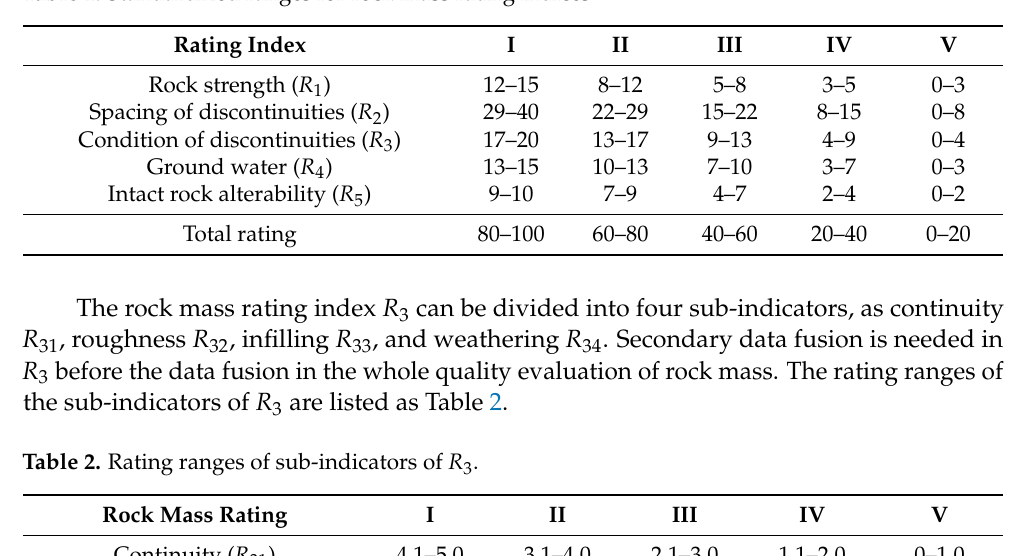
Table 1. Standardized ranges for rock mass rating indices.